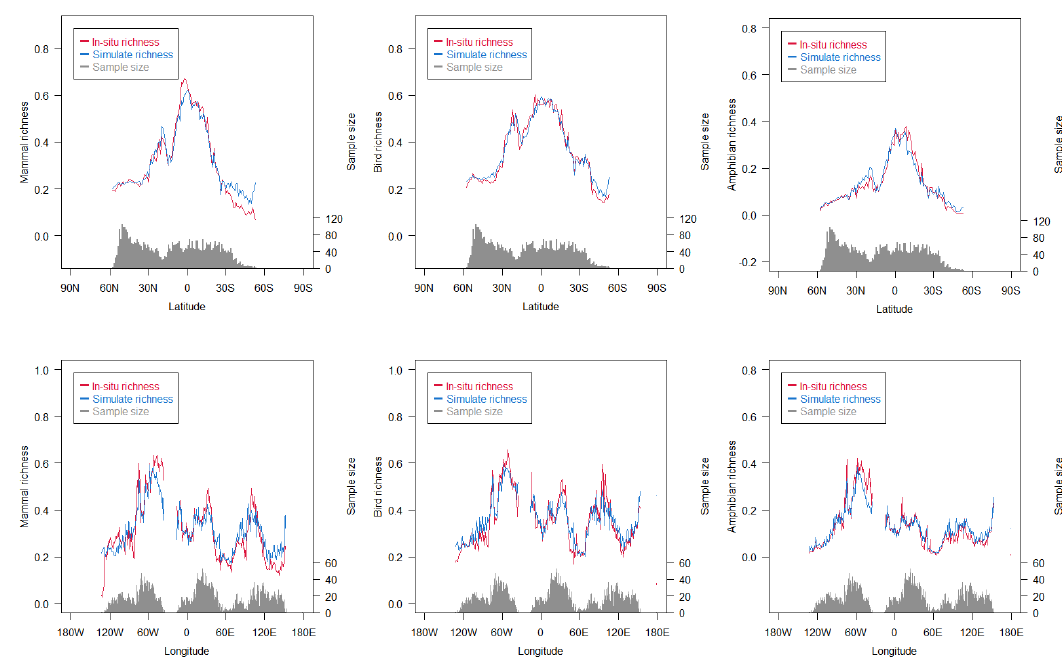
Figure 8. Distribution of simulated species richness and in situ species richness at latitudinal/longitudinal zones. The data are from a prediction dataset, which has 5000 samples.